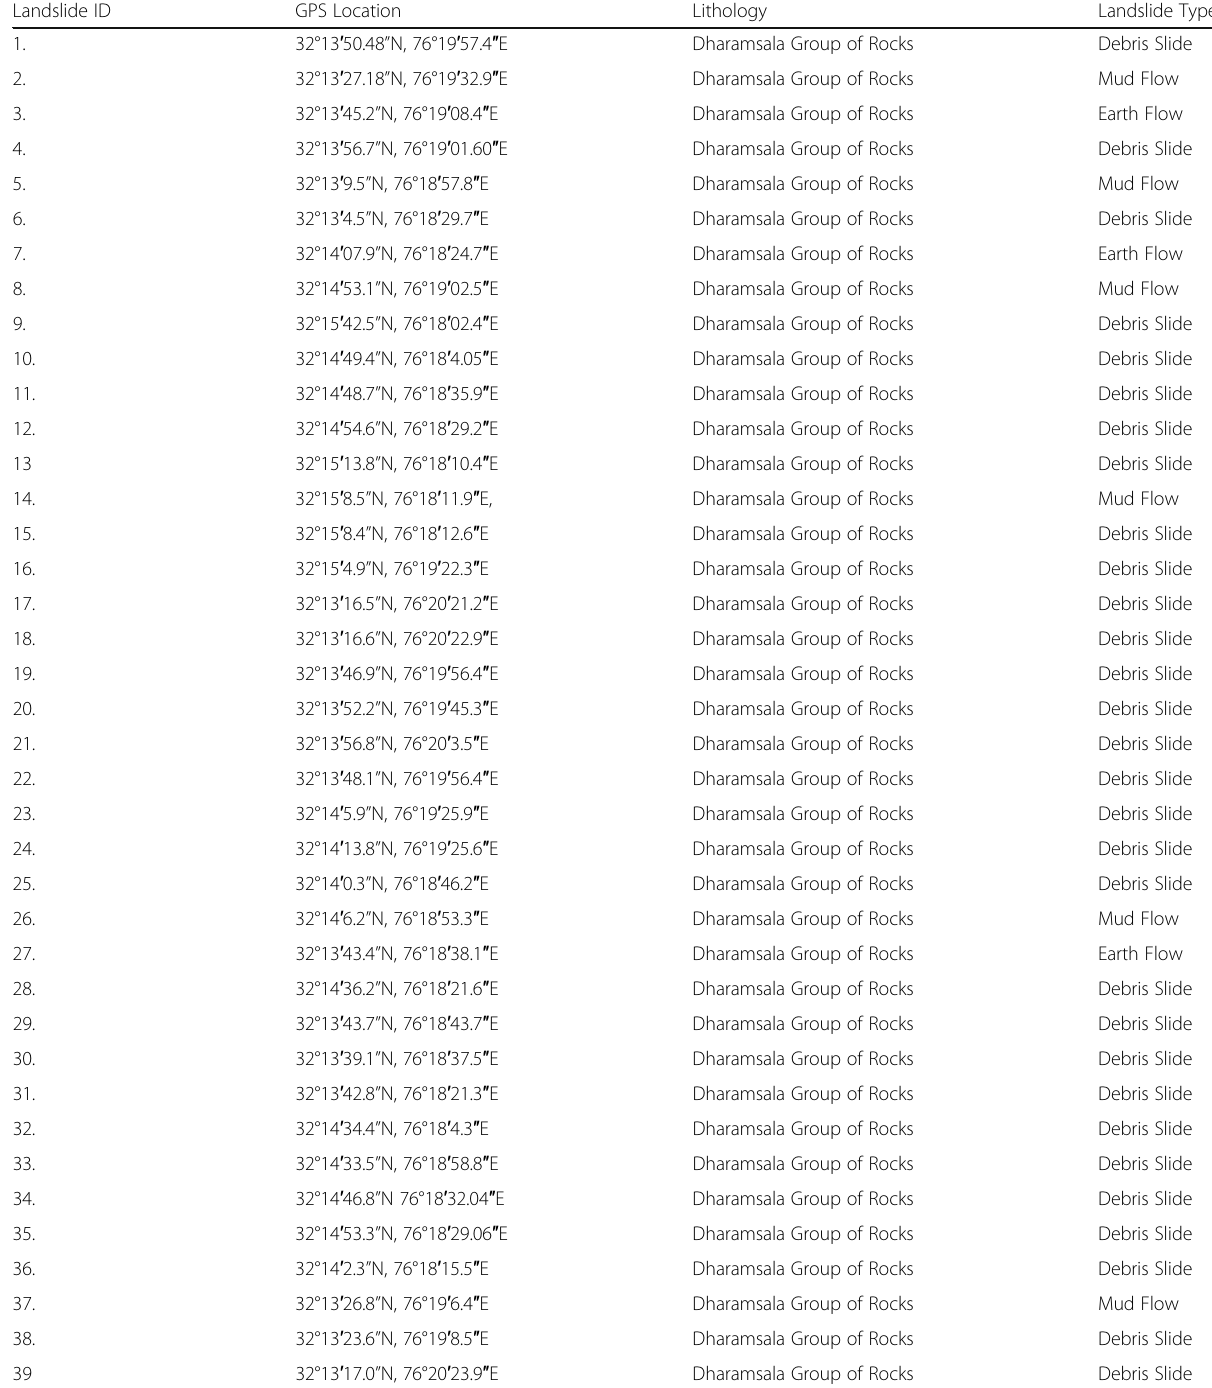
Table 2 Values of random index based on the size f the matrix Table 3 Landslide Inventory Locations Landslide